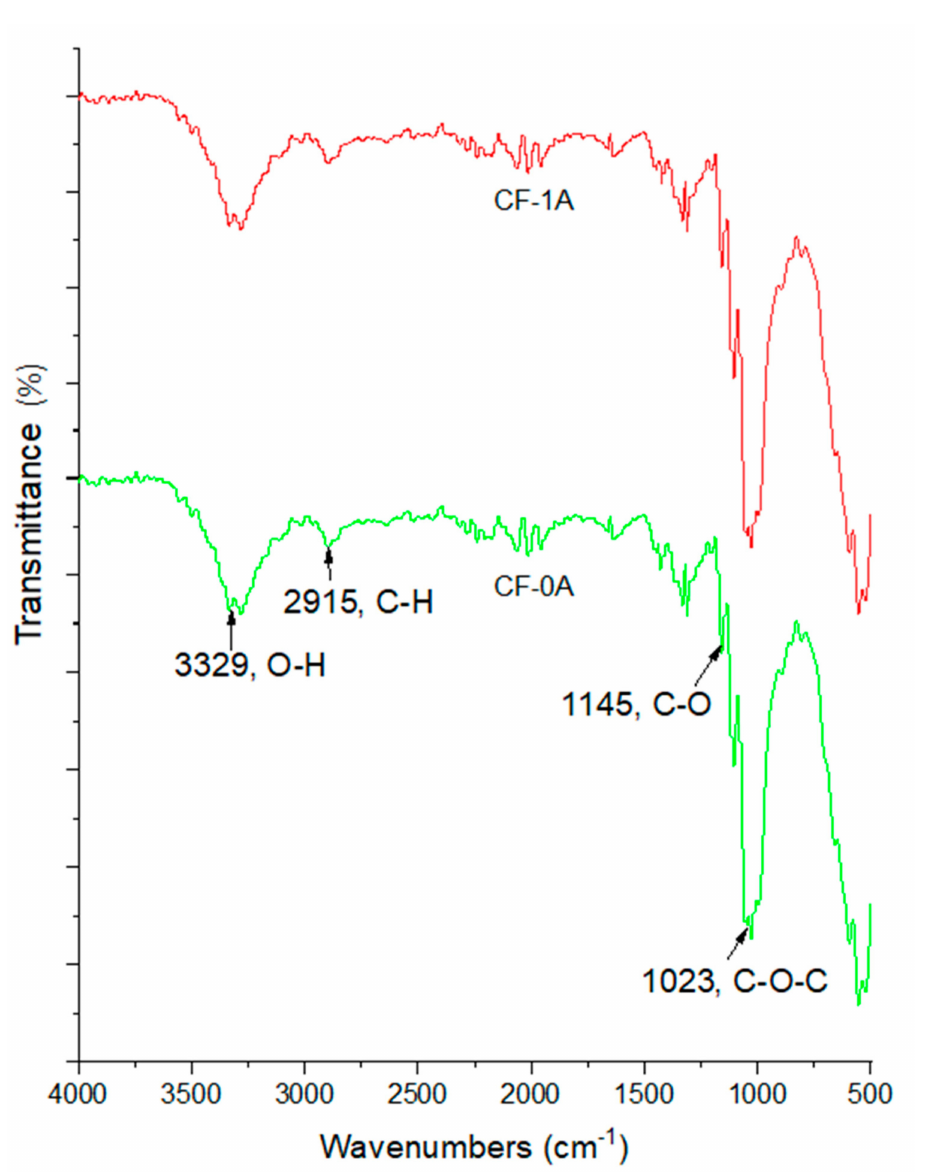
Figure 4. ATR-FTIR spectra of samples with and without deposition of AgNPs on the fabric surface.